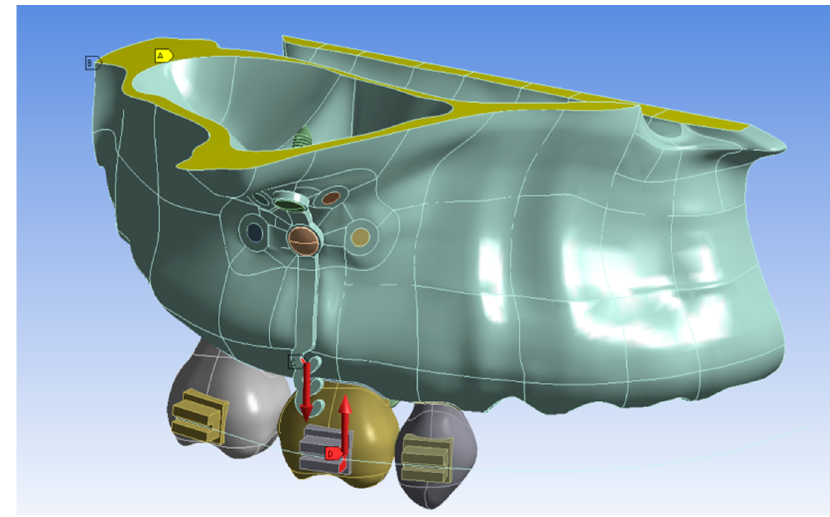
Figure 4. The direction of force application for posterior intrusion.